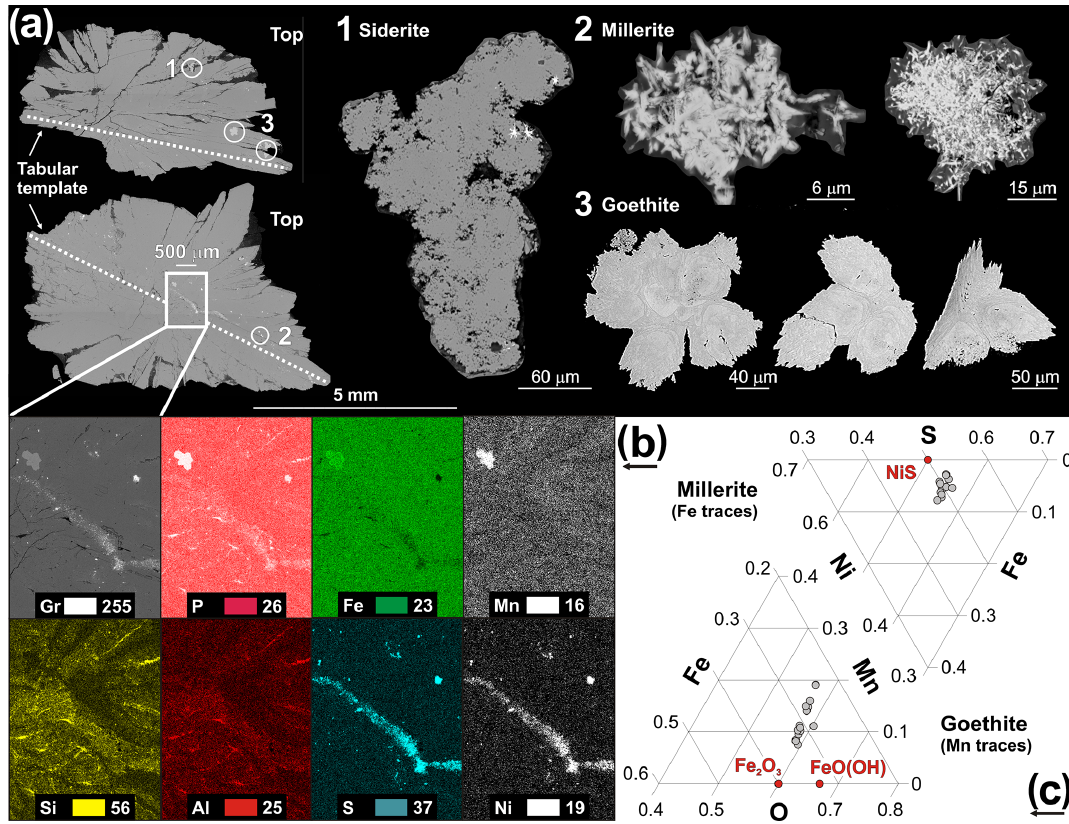
Figure 4. SEM images of vivianite crystal in axial section and close-ups of the mineral inclusions with EDX mapping and punctual analyses. (a) SEM images of an axial section of a vivianite crystal from 46.8m depth, with inclusions of siderite (1), millerite (2) and goethite (3). (b) EDX elemental mapping of the framed area with relative intensity images for grey levels (Gr), phosphorus (P), iron (Fe), manganese (Mn), silicon (Si), aluminum (Al), sulfur (S) and nickel (Ni). (c) Ternary diagrams displaying the elemental composition of millerite and goethite as measured by punctual EDX analyses. Millerite and goethite crystals contain traces of iron and manganese,